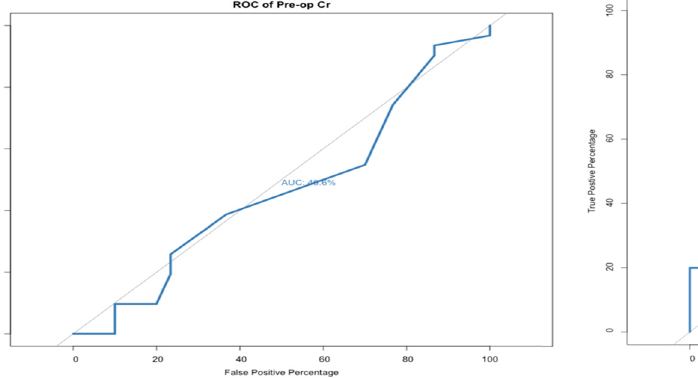
Figure 3: AUROC curve of preoperative creatinine ( OR = 0.8, p - value = 0.287, speci fi city = 13.3%, and sensitivity = 93.5% ) .